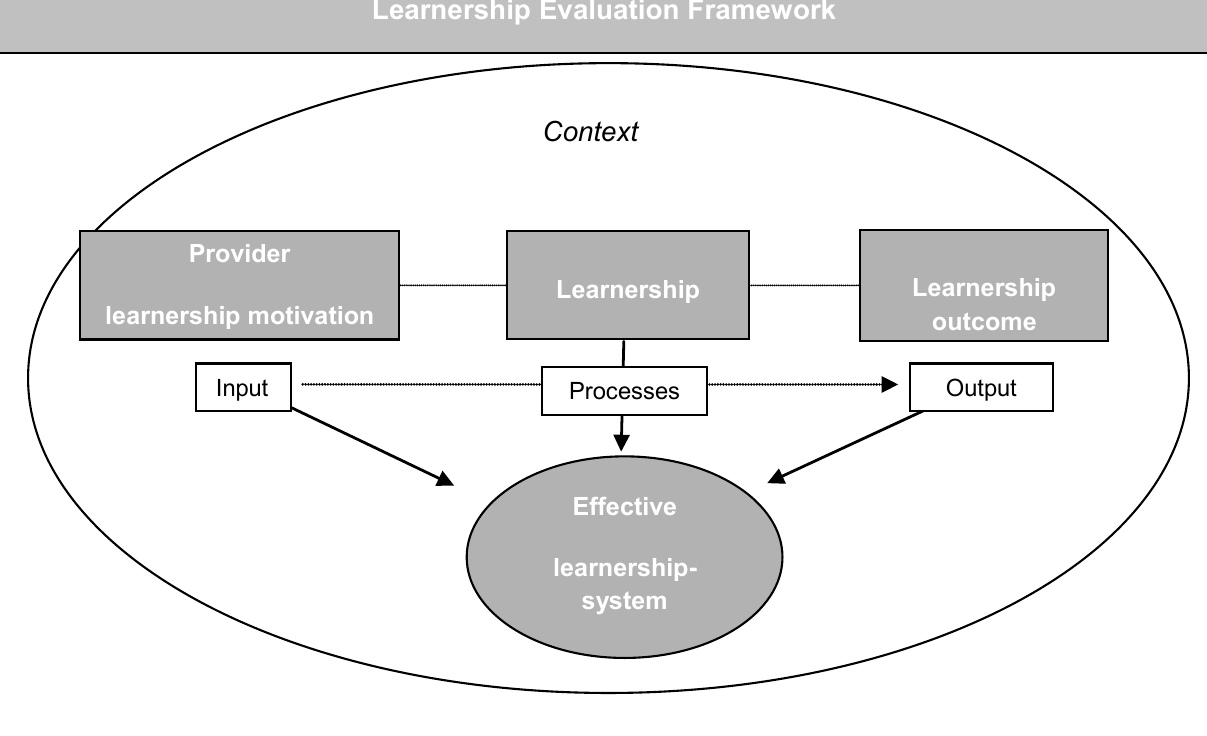
Figure 2: Learnership evaluation framework (Mummenthey, 2008, p. 68) FIGURE 2